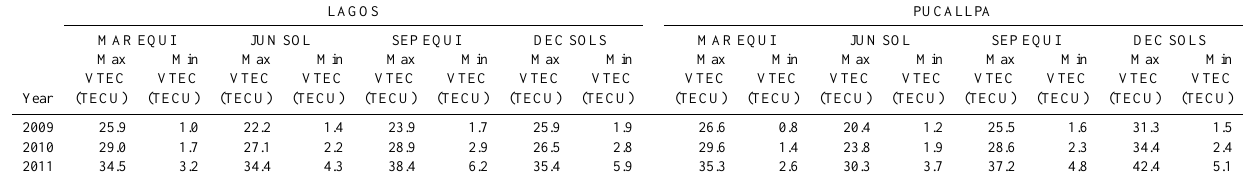
Table 1. Peak and minimum values of IRI-2007-derived TEC for all the seasons at Lagos and Pucallpa during 2009, 2010, and 2011. LAGOS PUCALLPA MAR EQUI JUN SOL SEP EQUI DEC SOLS MAR EQUI JUN SOL SEP EQUI DEC SOLS